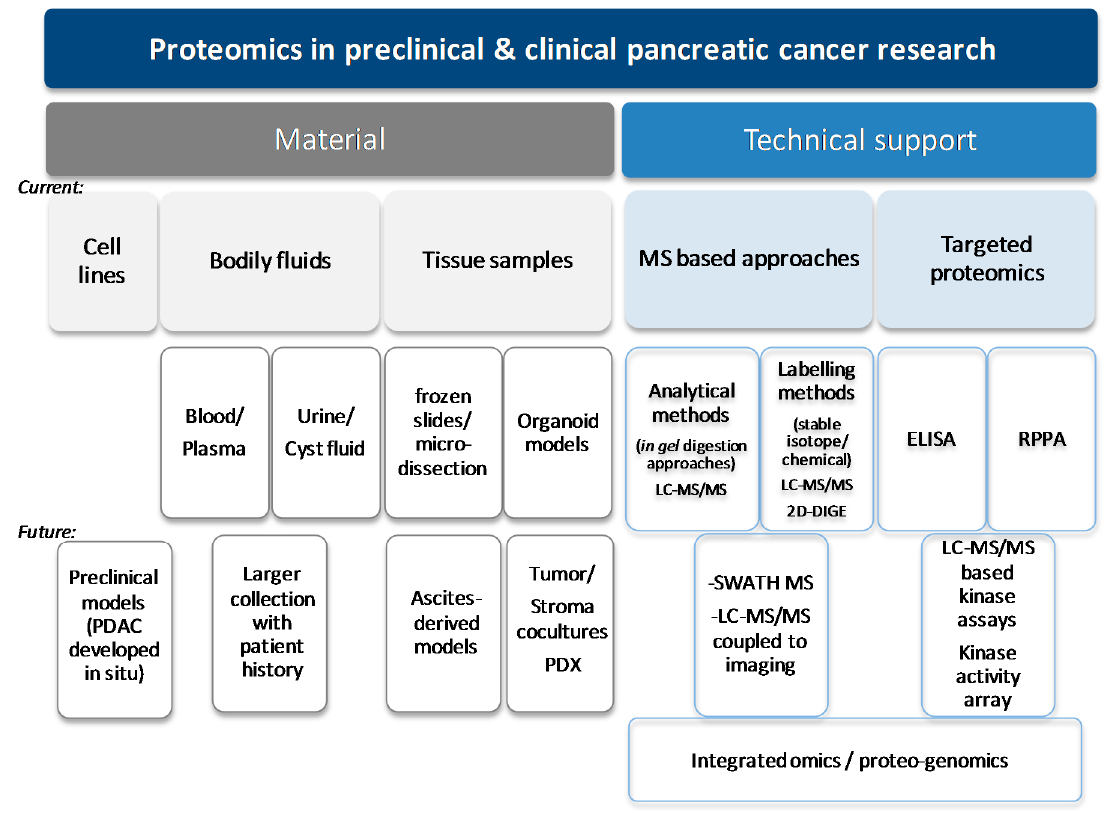
Figure 2. Major materials and technical tools used in preclinical pancreatic cancer research . RPPA: reverse phase protein array; ELISA: Enzyme-linked immunosorbent assay; LC-MS/MS: Liquid chromatography–tandem mass spectrometry; 2D-DIGE: two-dimensional differential gel electrophoresis; PDX: patient derived